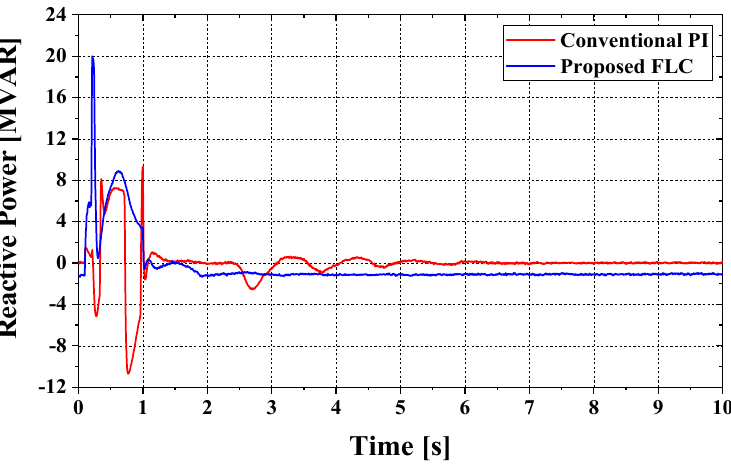
Figure 10. Reactive power profile of the conventional and proposed PV plants at bus 10.